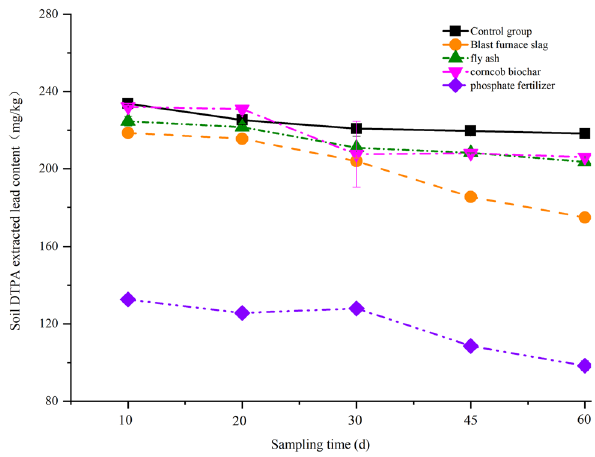
Figure 2: Variation of available Pb contents in soil after addition of di ff erent passivation